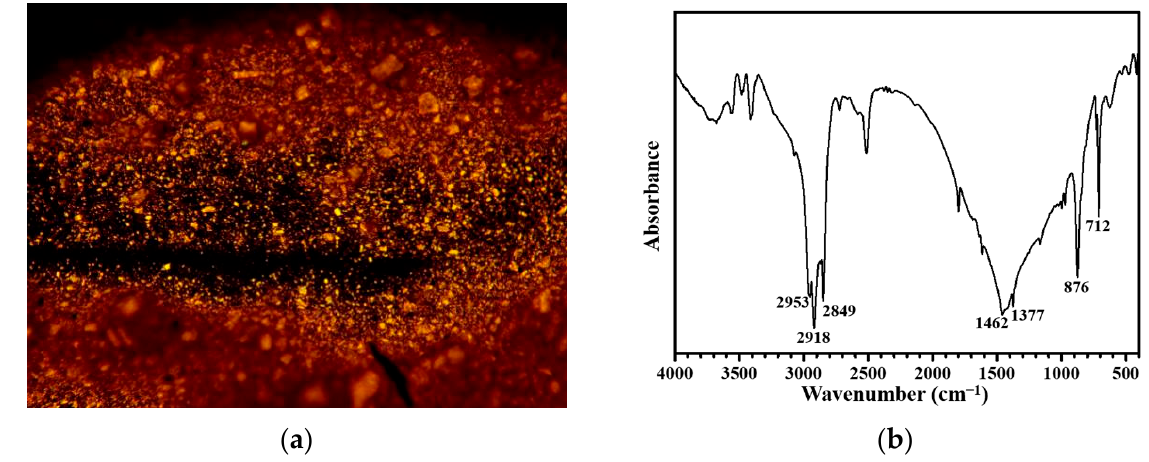
Figure 9. Microphotograph ( a ) and FTIR spectrum of PPW 380-1.0 ( b ).